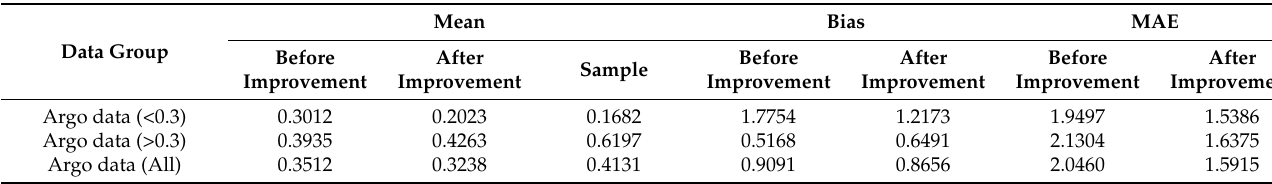
Table 11. Systematic deviation of the Argo data. “All” indicates the total Argo data; “>0.3” and “<0.3” indicate the group data based on a threshold Chl Argo concentration = 0.3 mg m − 3 .